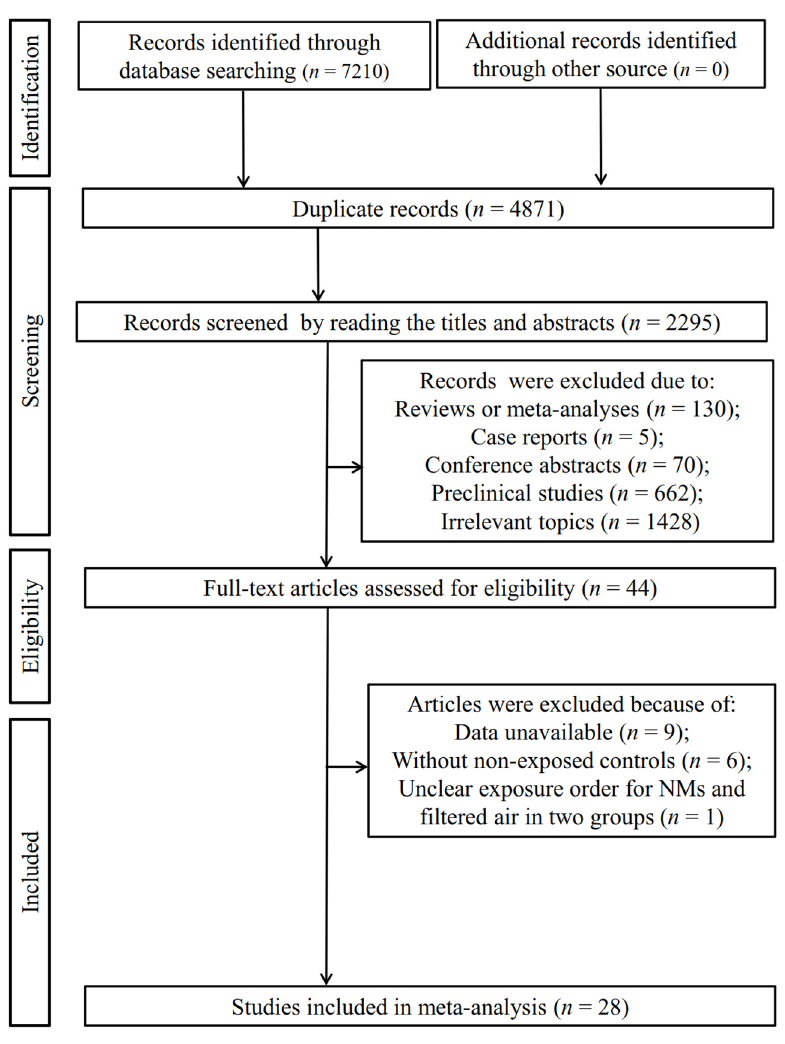
Figure 1. Flowchart of the literature search for the meta-analysis.